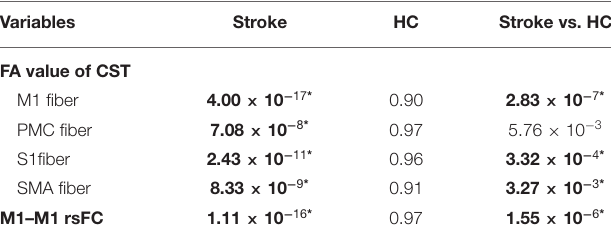
TABLE 2 | Longitudinal evolution patterns of CST and M1–M1 rsFC changes after subcortical stroke.